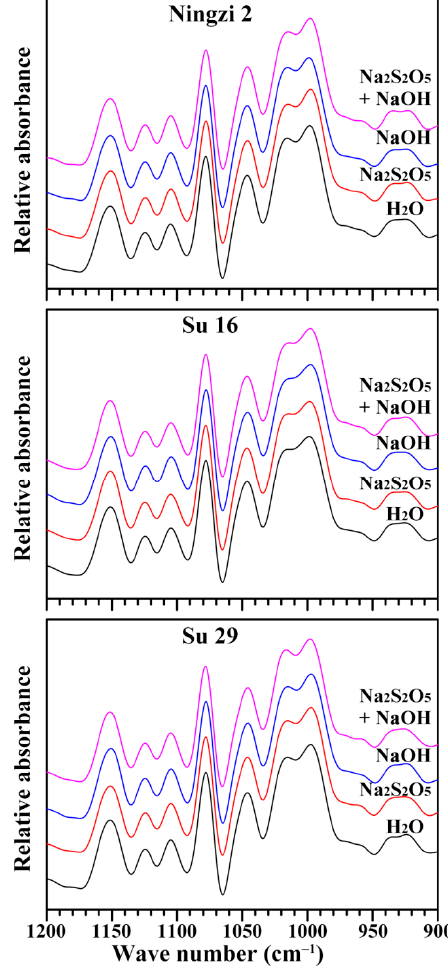
Figure 5. ATR-FTIR spectra of starches.